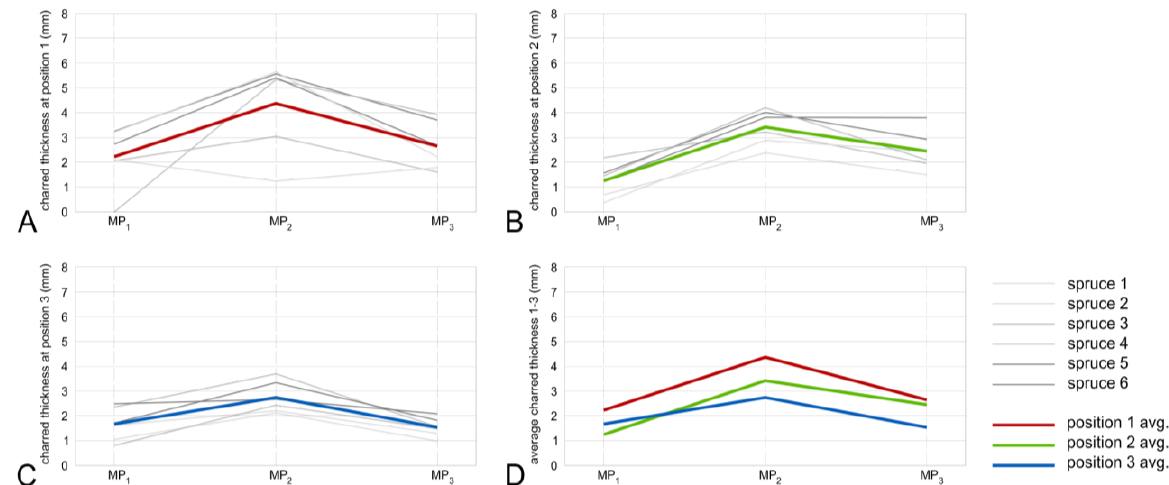
Figure 6. Spruce charred layer thickness in cutline 1—bottom ( A ), cut line 2—middle ( B ), cut line 3—top ( C ), and all average thicknesses ( D ).